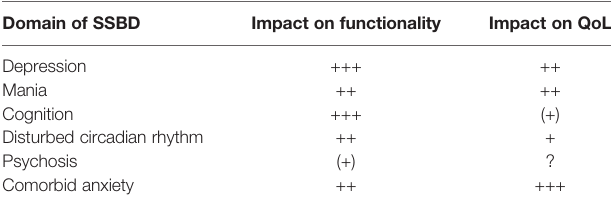
TABLE 1 | Summary of the proposed impact of the different domains of SSBD following an acute episode on functionality and QoL. Domain of